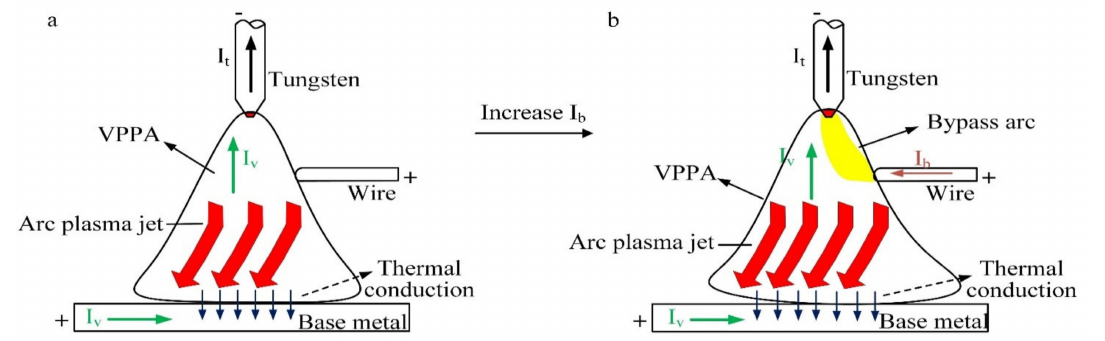
Figure 17. Schematic diagram of physics between bypass current variation and base metal heat input, ( a ) arc physics before bypass current changes, ( b ) arc physics after bypass current